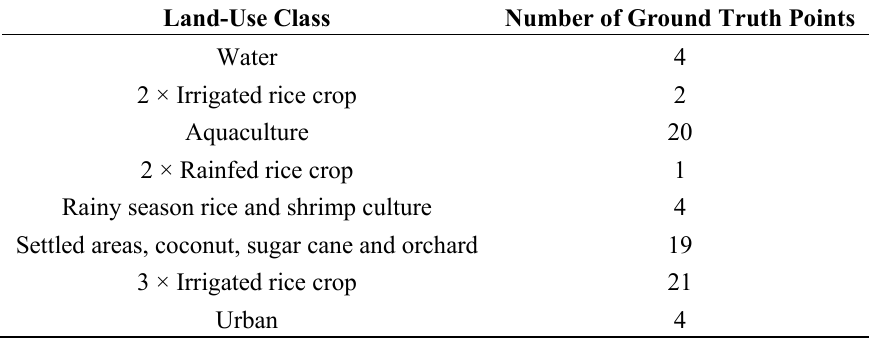
Table 3. Summary of the ground truth